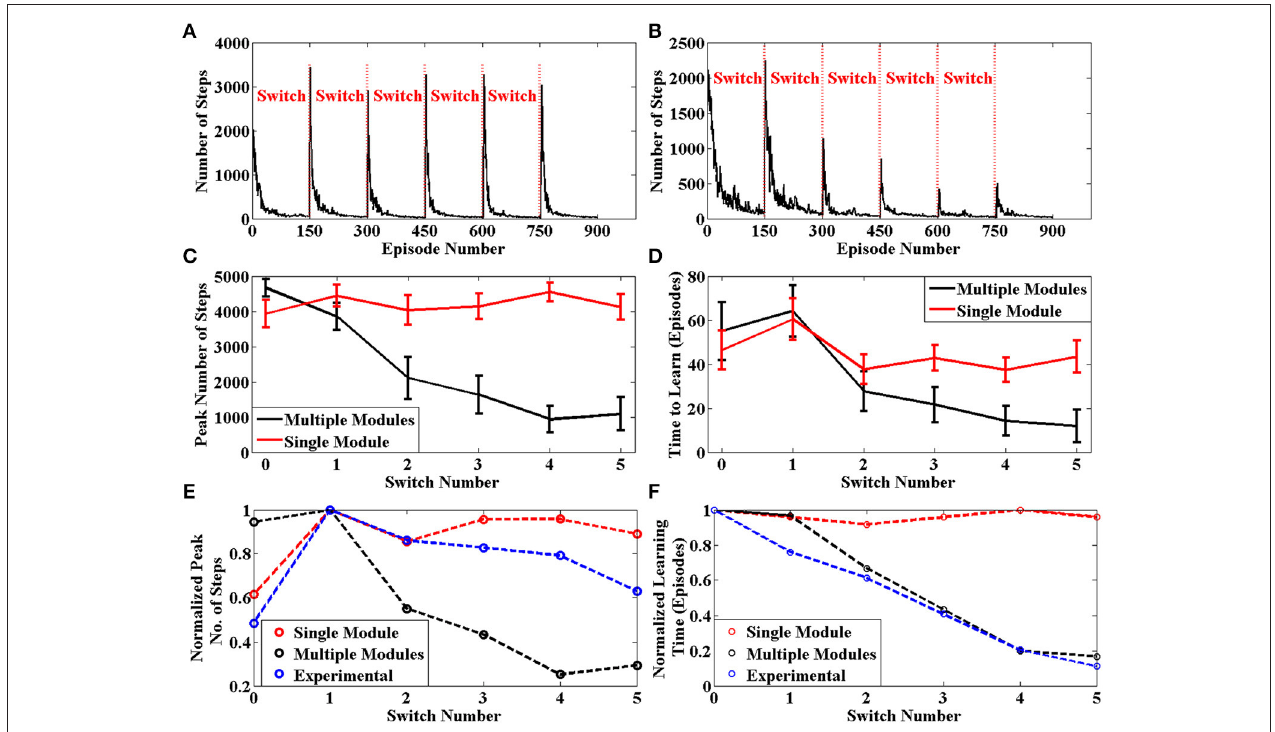
FIGURE 7 | (A) Plot of Number of Steps taken by the single module agent in each episode averaged across 50 independent sessions. We see that the agent needs to relearn after each context switch (B) Plot of Number of Steps taken by the multi module agent in each episode averaged across 50 independent sessions. We see that the agent efficiently switches modules after each context switch (C) Peak number of steps needed to reach the goal after a context switch averaged across 50 sessions. (D) Number of episodes for the number of steps required to reach the goal to go below a certain threshold averaged across 50 sessions (E) Peak value for the average number of steps needed to reach the goal after a context switch. The experimental values have been adapted from Brunswik (1939) (D) Number of episodes for the average number of steps required to reach the goal to go below a certain threshold. The experimental values have been adapted from Brunswik (1939)